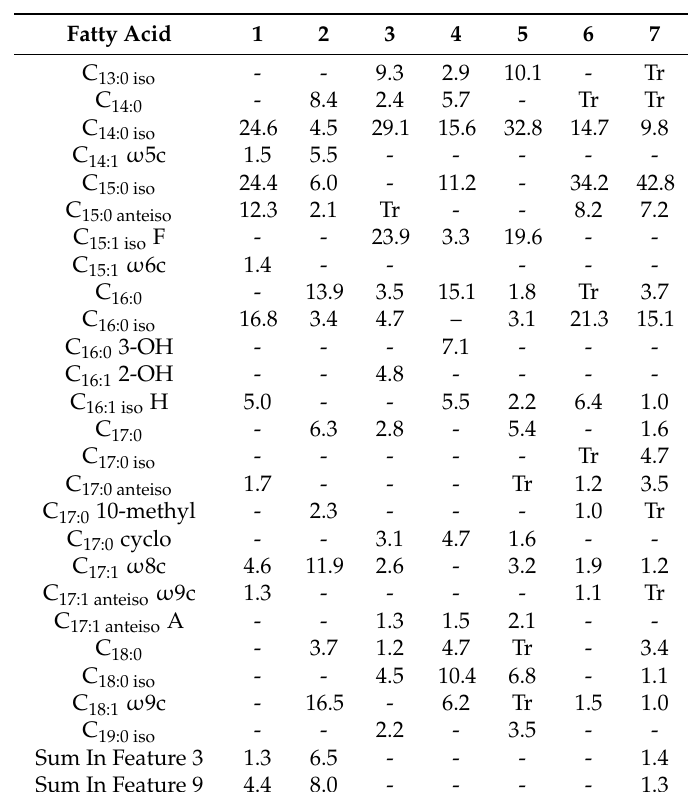
Table 3. Cellular fatty acid composition of Terrabacter humi MAHUQ-38 T and phylogenetically closely related Terrabacter species. Strains: 1, T. humi MAHUQ-38 T ; 2, T. tumescens KACC 20535 T ; 3, T. terrae KACC 11642 T ; 4, T. terrigena KCTC 19602 T ; 5, T. lapilli LR-26 T ; 6, T. ginsengihumi KACC 19444 T and 7, T. aerolatus KACC 20556 T